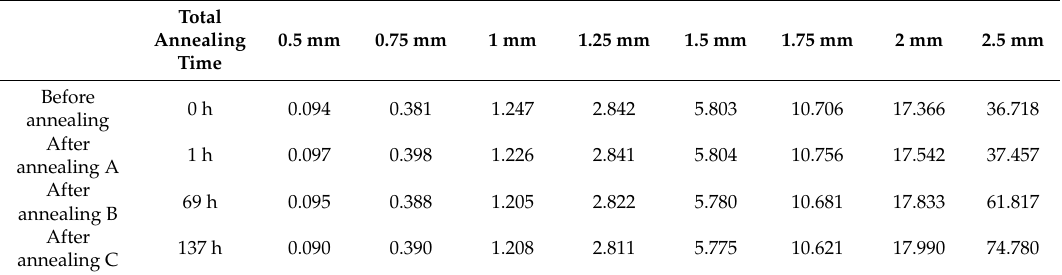
Table 3. The averaged maximum deflections (µm) with respect to the diaphragm radius at 600 °C.